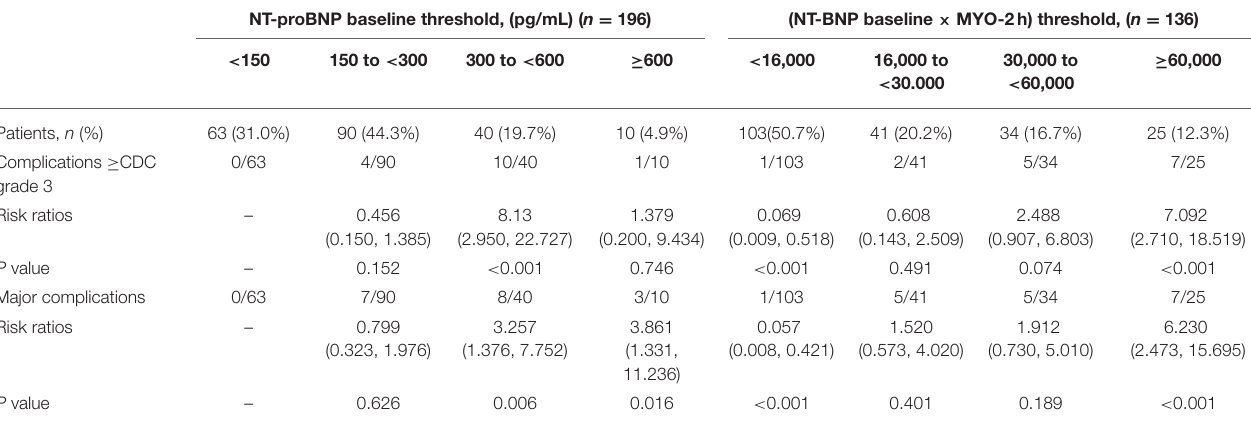
TABLE 4 | Association between NT-proBNP baseline/(NT-proBNP baseline × MYO-2h) and 30-day